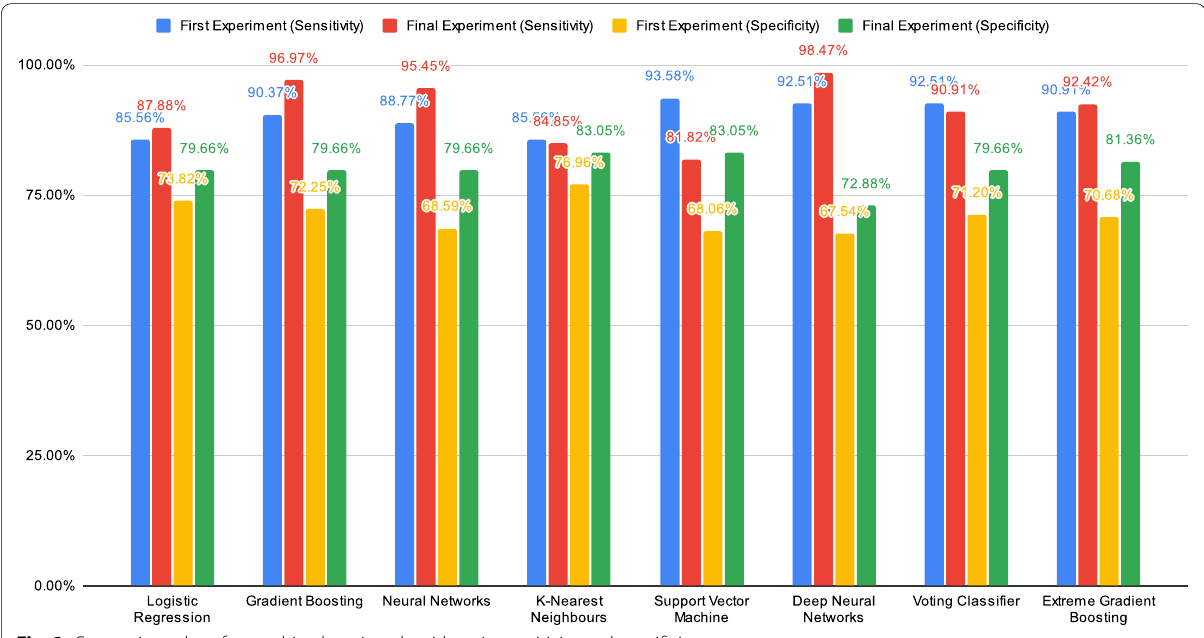
Fig. 2 Comparison chart for machine learning algorithms in sensitivity and